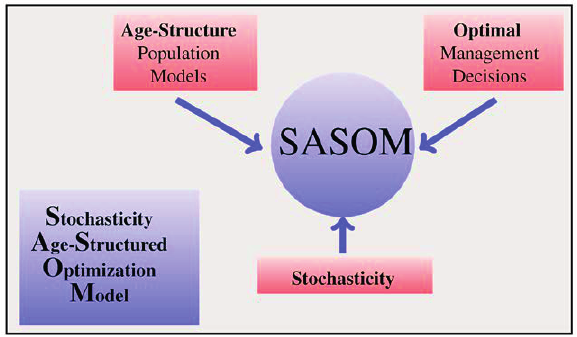
Fig. 1. – The main characteristics of the SASOM approach.